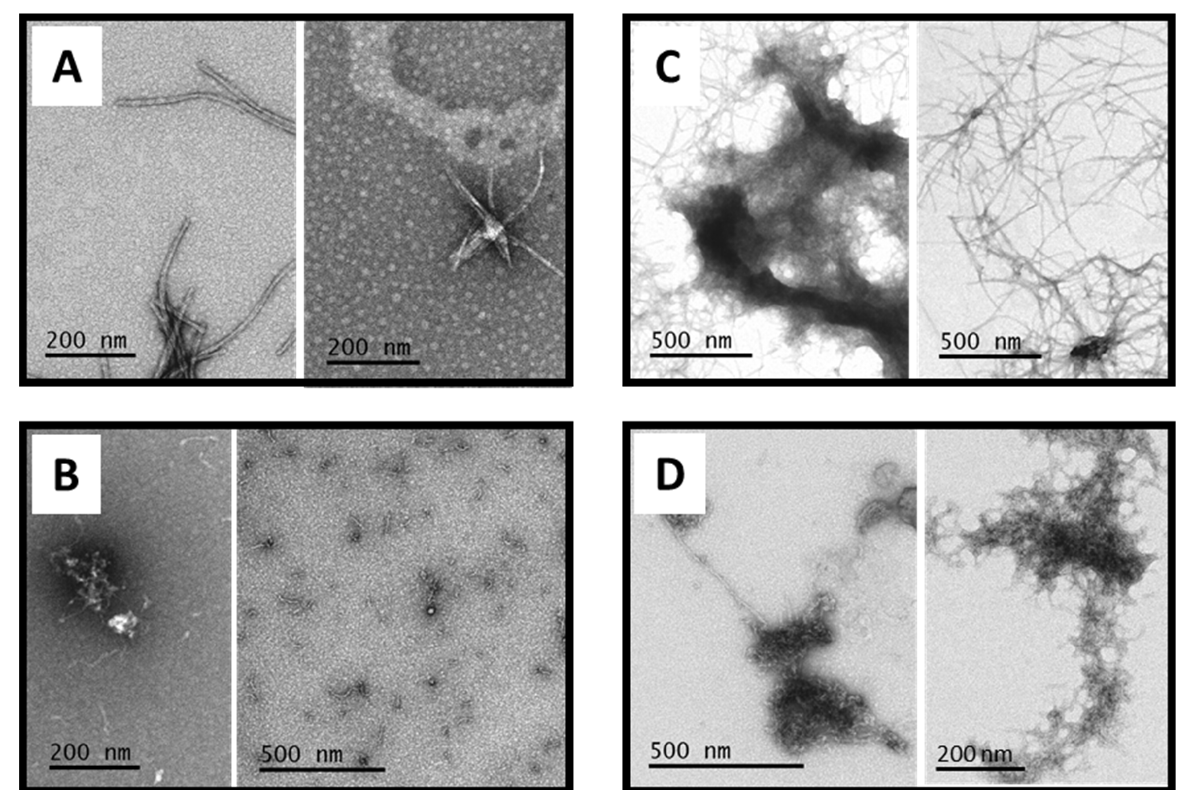
Figure 6. Kinetic monitoring of A β 1–40 and ox A β 1–40 co-assembly in presence of Cu(II) or Zn(II) using ThT fluorescence. Curves are shown as triplicate. [A β 1–40 ] = 20 µM (black); [A β 1–40 ] = [ ox A β 1–40 ] = 10 µM (green); [ ox A β 1–40 ] = 20 µM (blue). Apo peptides (dashed curves) with Cu(II) (18 µM, solid curves, left panel) or Zn(II) (18 µM, solid curves, right panel) at pH 7.4. Data from Experiment N°1: HEPES buffer 50 mM, NaCl 65 mM. Y-axis corresponds to ThT fluorescence in arbitrary unit (a.u.); data are directly comparable between them (same y-scale).